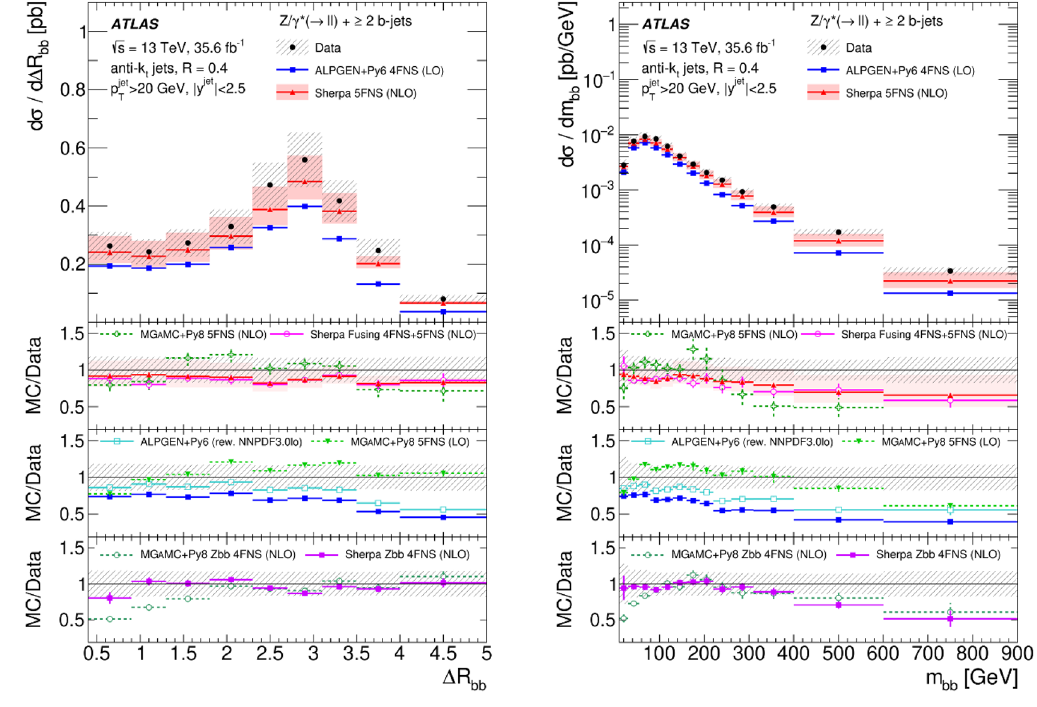
Figure 13 . Measured cross-section as a function of (cid:1) R between the two leading b -jets (left) and invariant mass of the two leading b -jets (right) in events with at least two b -jets. The data are compared with the predictions from Sherpa 5FNS (NLO) , Alpgen + Py6 4 FNS (LO) , Sherpa Fusing 4FNS+5FNS (NLO) , Sherpa Zbb 4FNS (NLO) , MGaMC + Py8 5FNS (LO) , MGaMC + Py8 Zbb 4FNS (NLO) and MGaMC + Py8 5FNS (NLO) . The error bars correspond to the statistical uncertainty, and the hatched bands to the data statistical and system- atic uncertainties added in quadrature. The red band corresponds to the statistical and theoretical uncertainties of Sherpa 5FNS (NLO) added in quadrature. Only statistical uncertainties are shown for the other